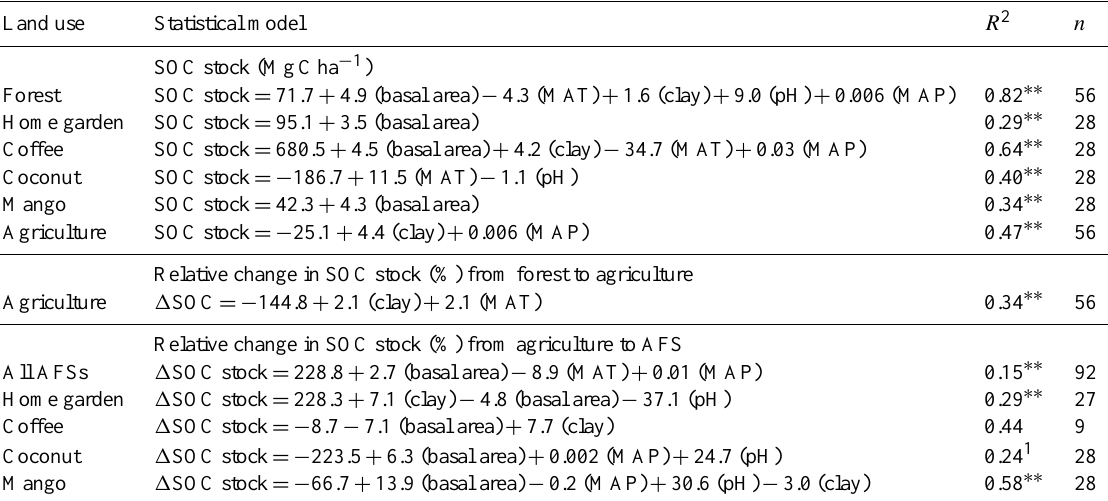
Table 2. Multivariate regression models predicting SOC stocks in different land-use systems and the relative changes in SOC stock (%) from either forest or agriculture references in the 100cm soil profile. MAP is mean annual precipitation (mm), MAT is mean annual temperature ( ◦ C), clay fraction (%) and basal area (m 2 ha − 1 ).